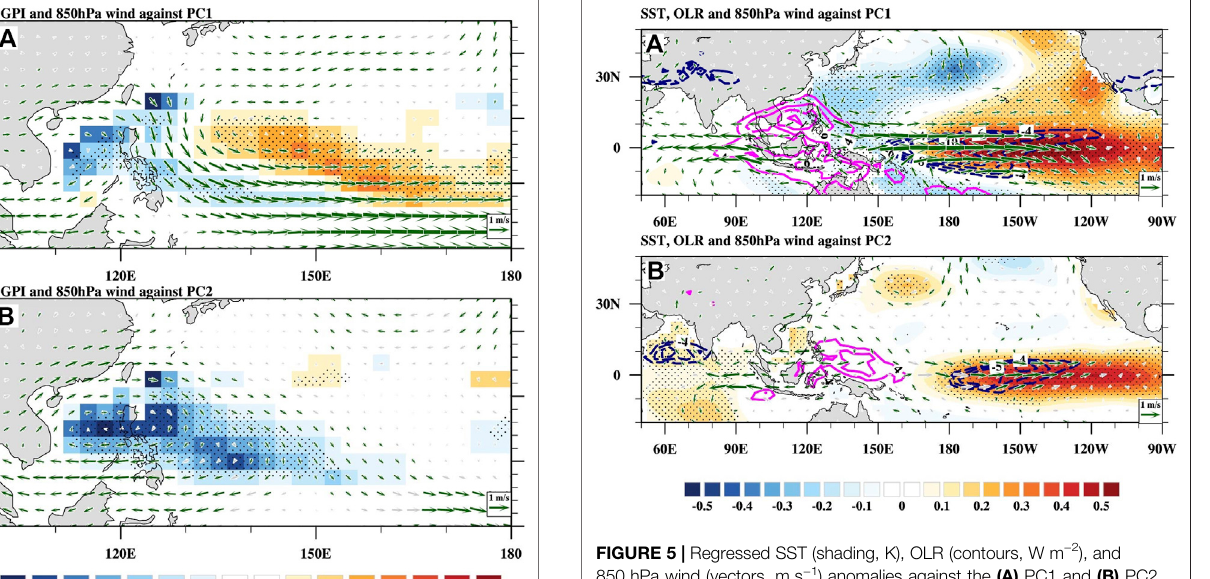
Frontiers in Earth Science |